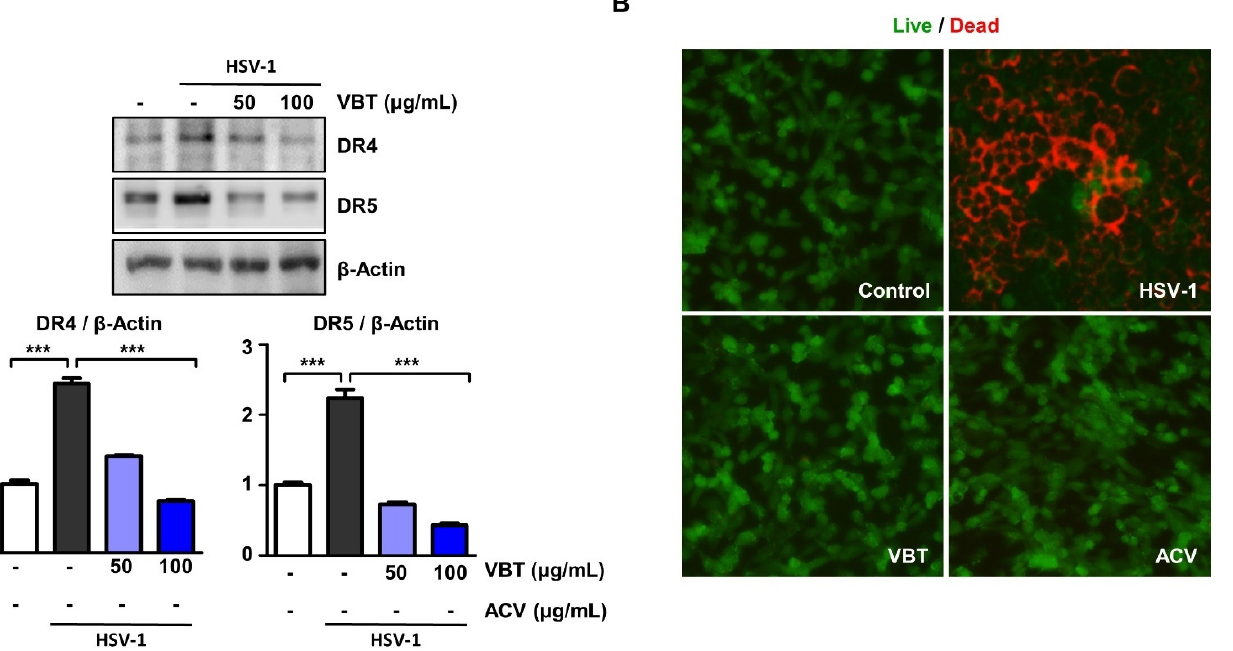
Figure 6. Protective effect of VBT against HSV-1 induced apoptosis in SK-N-SH cells. SK-N-SH cells were infected with HSV-1 at MOI = 0.1 for 2 h. Then, the infectious agent medium was removed and replaced with fresh medium, and VBT was added at 50 μ g/mL or 100 μ g/mL for 48 h. ( A ) The ex- pression of genes that were involved in DRs makers following HSV-1 infection was measured using Western blot analysis. ( B ) Live/Dead cell staining of SK-N-SH cells. The green color represents live